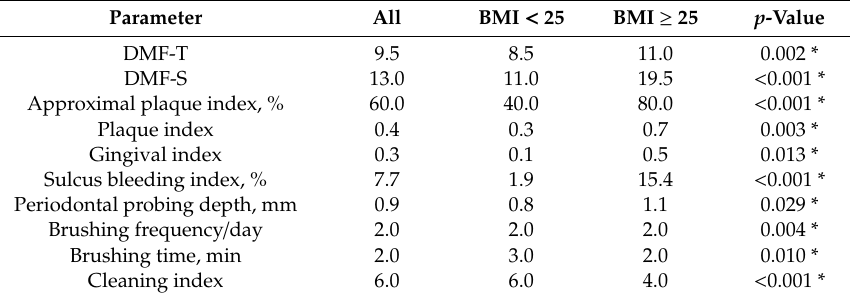
Table 2. Medians of assessed dental parameters in patients.